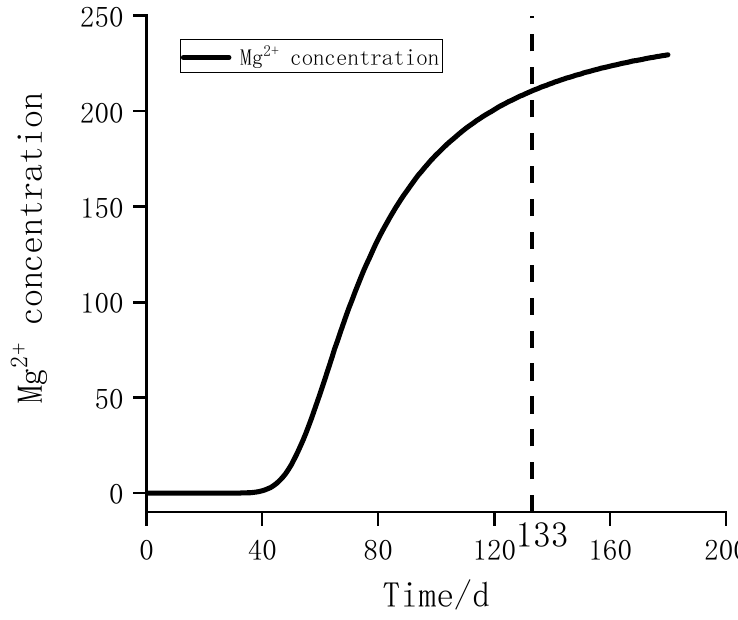
Figure 15. Time–history curve of the Mg 2+ concentration at the lower boundary. According to the cloud diagram of the Mg 2+ migration profile in the stope, as shown in Figure 16, different colors in the cloud image represent different concentrations of magnesium ions, and the concentration of magnesium ions increases as the cloud color changes from blue to red. With the mining of the test stope, limited by the strength of the injection liquid, magnesium ions cross the topsoil layer and reach the ore-bearing layer on the 7th day, and begin exchange reactions with spherical particles in the reaction particle bed in the model, replacing rare earth ions, and Mg 2+ is adsorbed back on the particle surface. With the passage of time, the concentration of Mg 2+ in the ore-bearing layer increases slowly, replacing the rare earth ions and adsorbing on the surface of the particle reaction bed. The adsorption line of Mg 2+ migrates downward with the expansion of the flow field. It can be seen from the profile that the injected Mg 2+ gathers at the foot of the mountain, and this part of the soil reaches its highest concentration the fastest, which accelerates the leaching process of rare earth. The rare earth elements at the foot of the mountain leach out the earliest and fastest. The content of Mg 2+ in the soil increases significantly. After leaching is completed, it is necessary to inject clean water into the stope to clean the original mountain otherwise Mg 2+ will flow into the river and infiltrate the ground with the arrival of the rainy season and will pollute the surface water and groundwater, resulting in the hardness index of the water body exceeding the standard and posing a threat to people’s